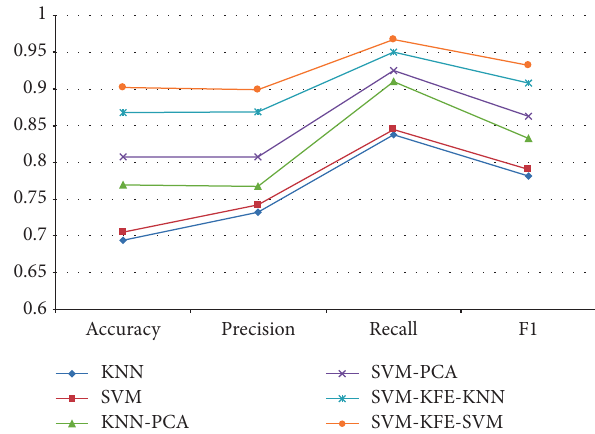
Figure 11: The comparison of algorithm performance when P ≤ 0 . 05.